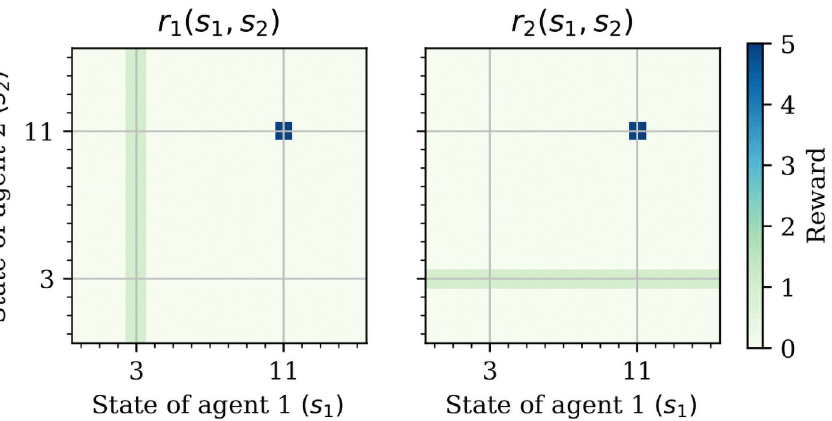
Fig 5. Markov stag-hunt reward functions. Darker colors indicate larger rewards. Agents receive a reward at each time step depending on their state and the state of the other agent. The hare state (state 3) can be obtained regardless of where the other agent is. This also allows us to model situations in which an agent can only obtain a big reward if the other agent is willing to coordinate with him. In our case, the stag state (i.e., state 11) has one such big, but difficult to obtain